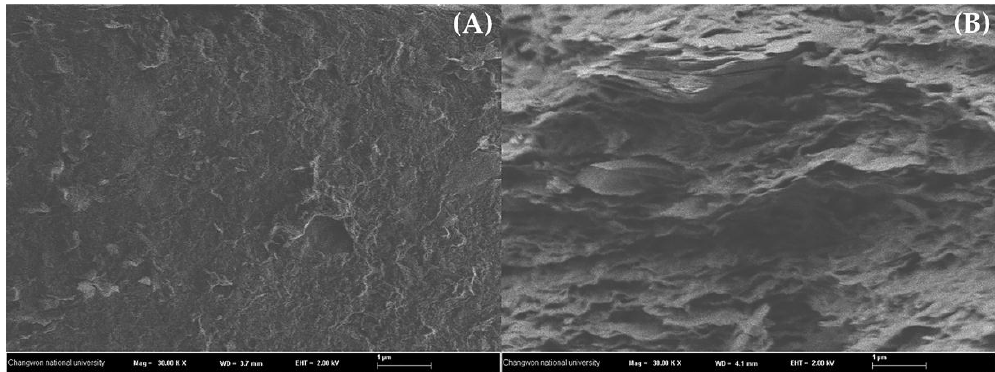
Figure 8. SEM images of ( A ) GO surface and ( B ) cross-section. Table 4. Isotherm parameters for the adsorption of BPA by GO at different